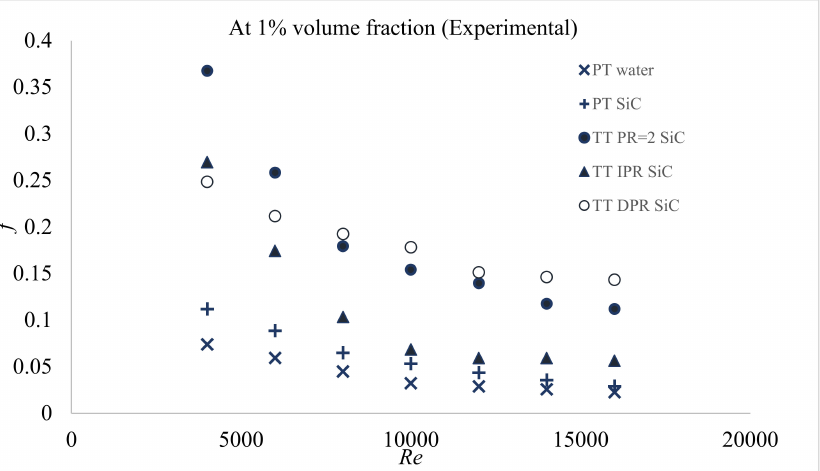
Figure 18. E ff ect of the type of inserts on f (Numerical).